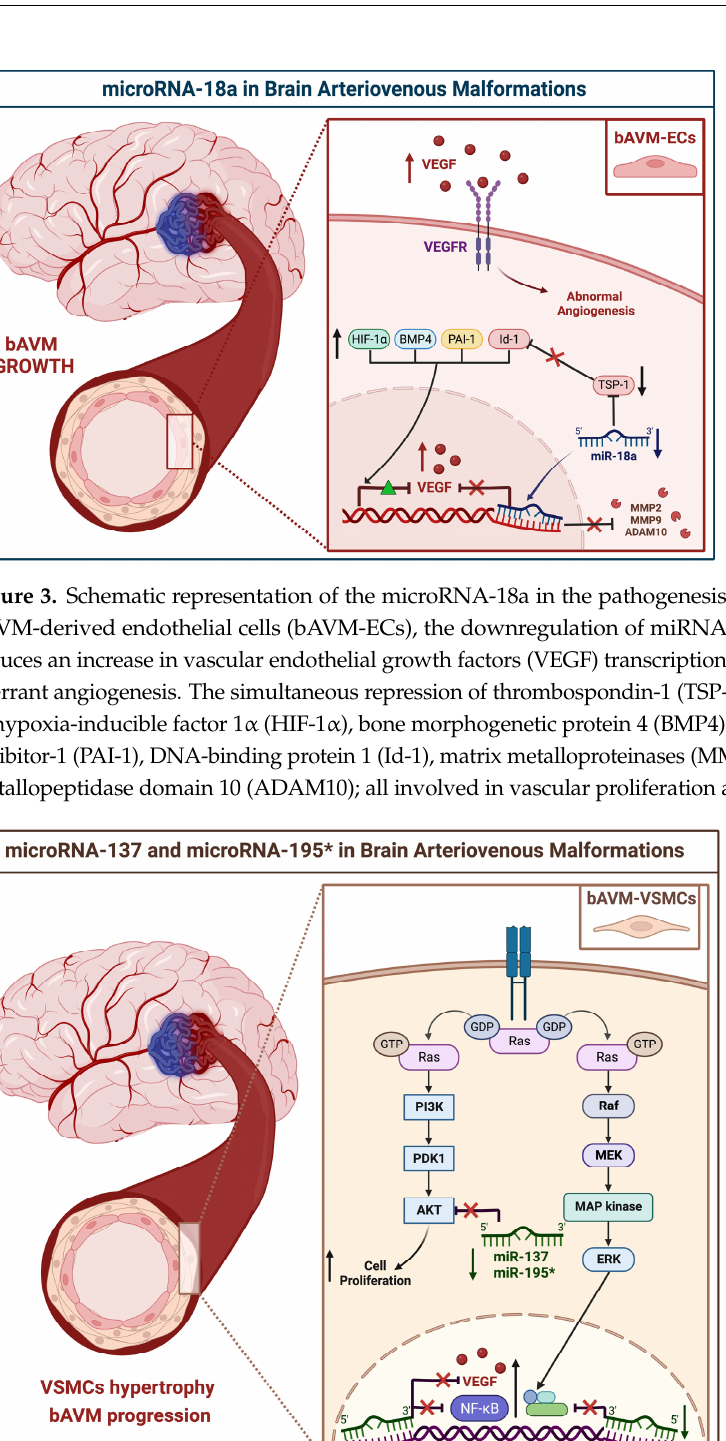
Figure 4. Schematic representation of the microRNA-137 and -195* in the pathogenesis of brain AVMs. The downregulation of miR-137 and miR-195* in the vascular smooth muscle cells (VSMCs) increases the RAS-related pathways, such as the phosphoinositide 3-kinase (PI3K)/protein kinase D1(PDK1)/protein kinase B (Akt) and rapidly accelerated fibrosarcoma kinases (Raf)/mitogen- activated protein kinase (MAP kinase)/extracellular signal-regulated kinase (ERK), all involved in VSMCs phenotype switching and cellular growth. The reduced activity of miR-137 and miR-195* also triggers the transcription of vascular endothelial growth factor (VEGF) and nuclear factor kappa- light-chain of activated B cells (NFkB), all linked to inflammation signals and aberrant angiogenesis. GDP: Guanosine diphosphate; GTP: Guanosine 5 (cid:48)